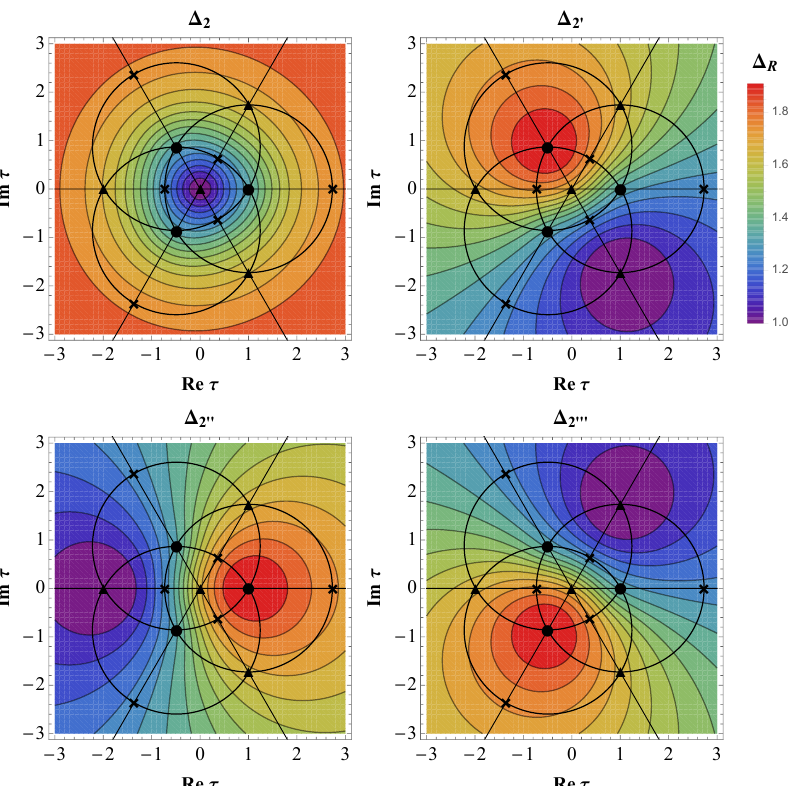
Figure 3 . The 3-loop Pad(cid:19)e[1,2] resummed 4 (cid:0) " -expansion values for the doublets. The cross, circle, and triangle denote values of (cid:28) that correspond to the Z 2 (cid:2) Z 2 , cWZ 3 , and XYZ models,